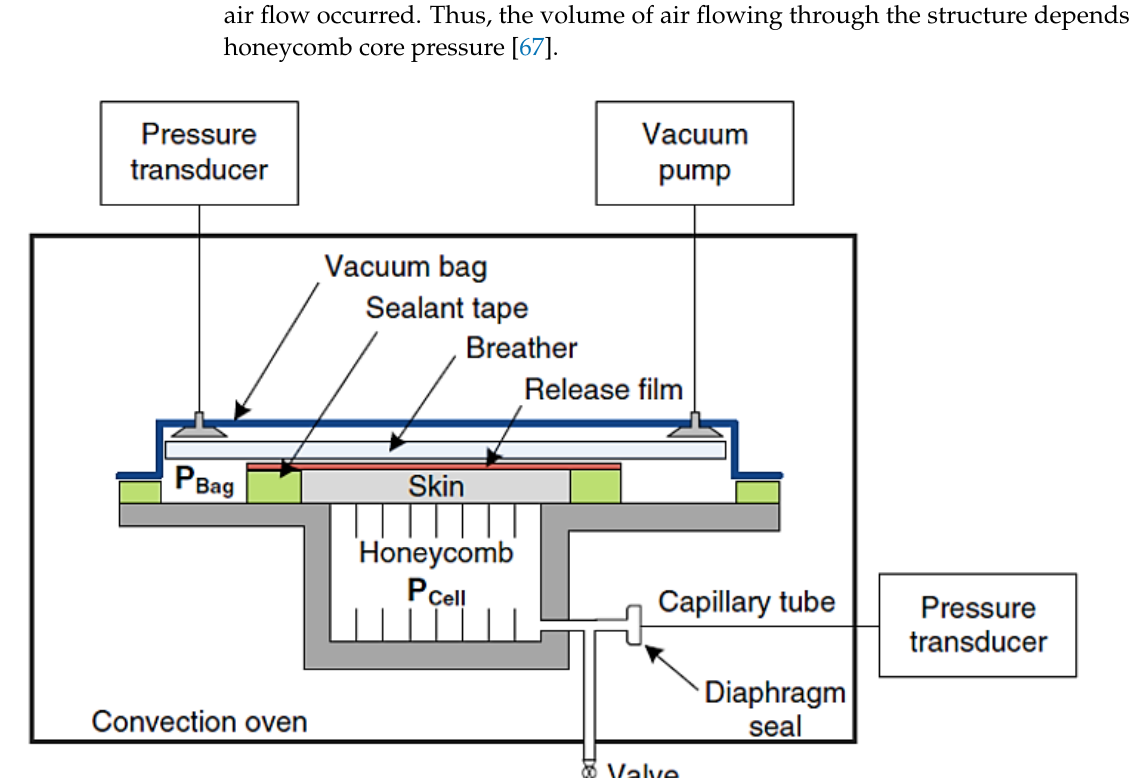
Figure 4. Schematic of pressure application on a honeycomb core during vacuum bagging pro- cessing [66]. Reproduced with permission from Elsevier. ing [66]. Reproduced with permission from